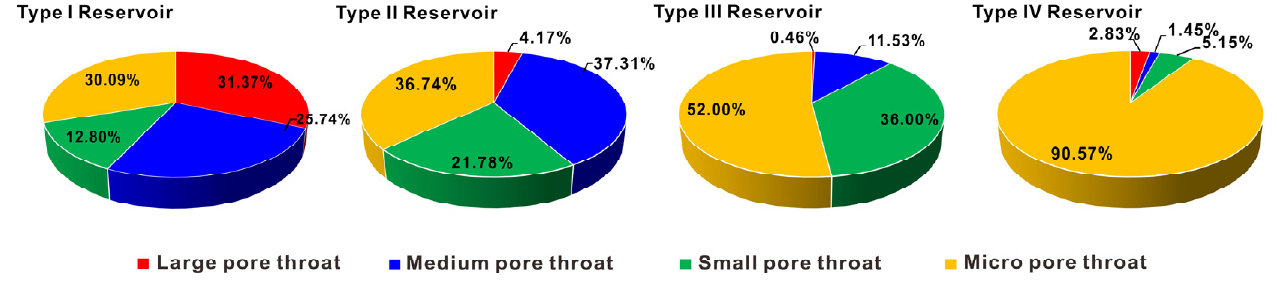
Figure 8. Pore-throat development characteristics of different types of reservoirs.